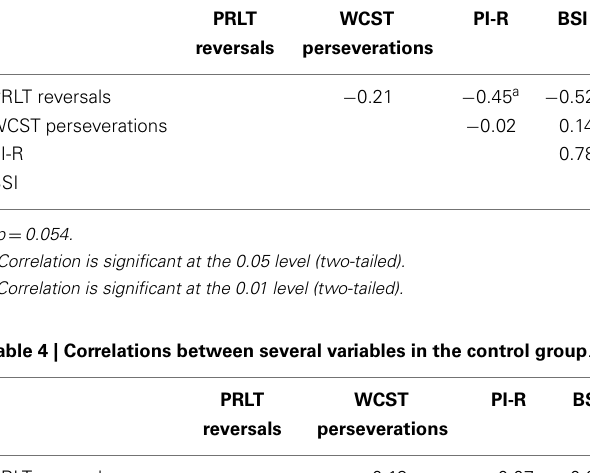
Table 3 | Correlations between several variables in the GD-group .